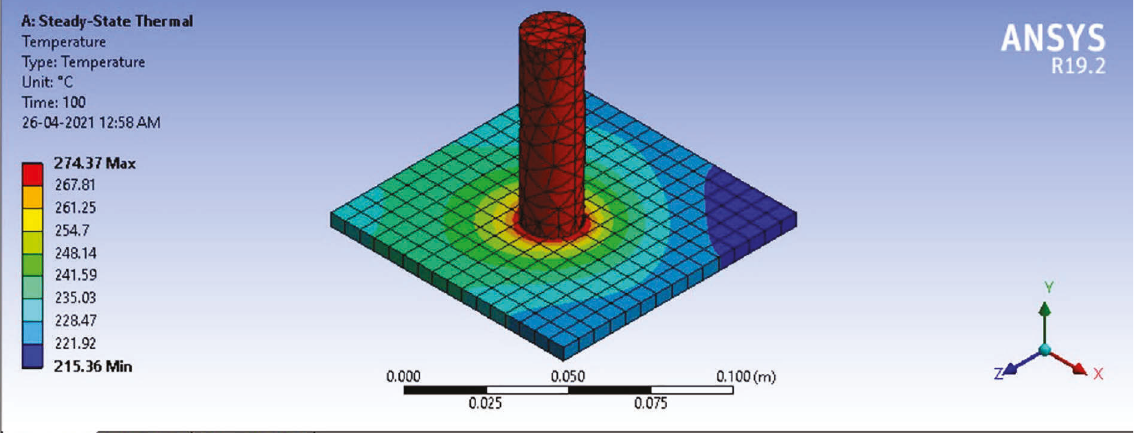
Figure 10: Temperature distribution.